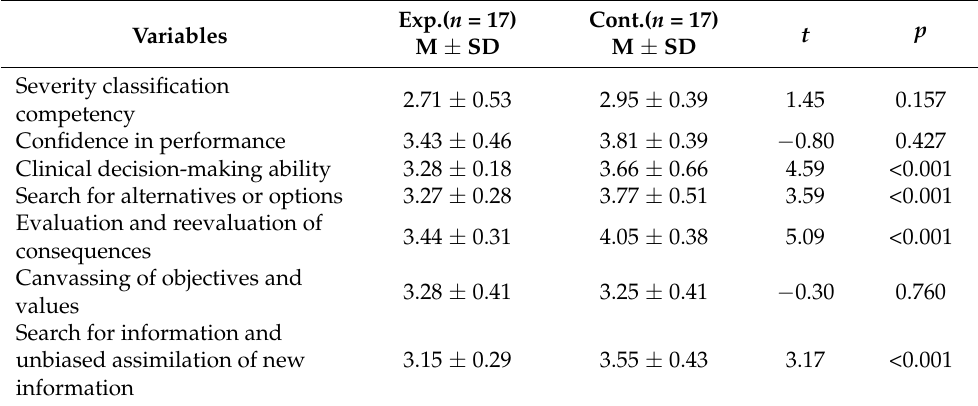
Table 2. Pretest Homogeneity between the Experimental and Control Groups ( n =